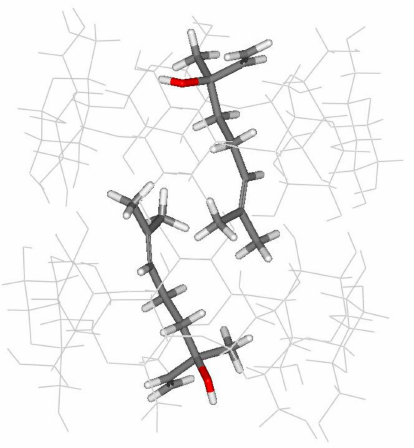
Figure 5. The crystal structure of ( R )-linalool/BCD [2:2] dimeric complex (UKIXAP). BCD molecules are presented as line models. Linalool molecules are presented as stick